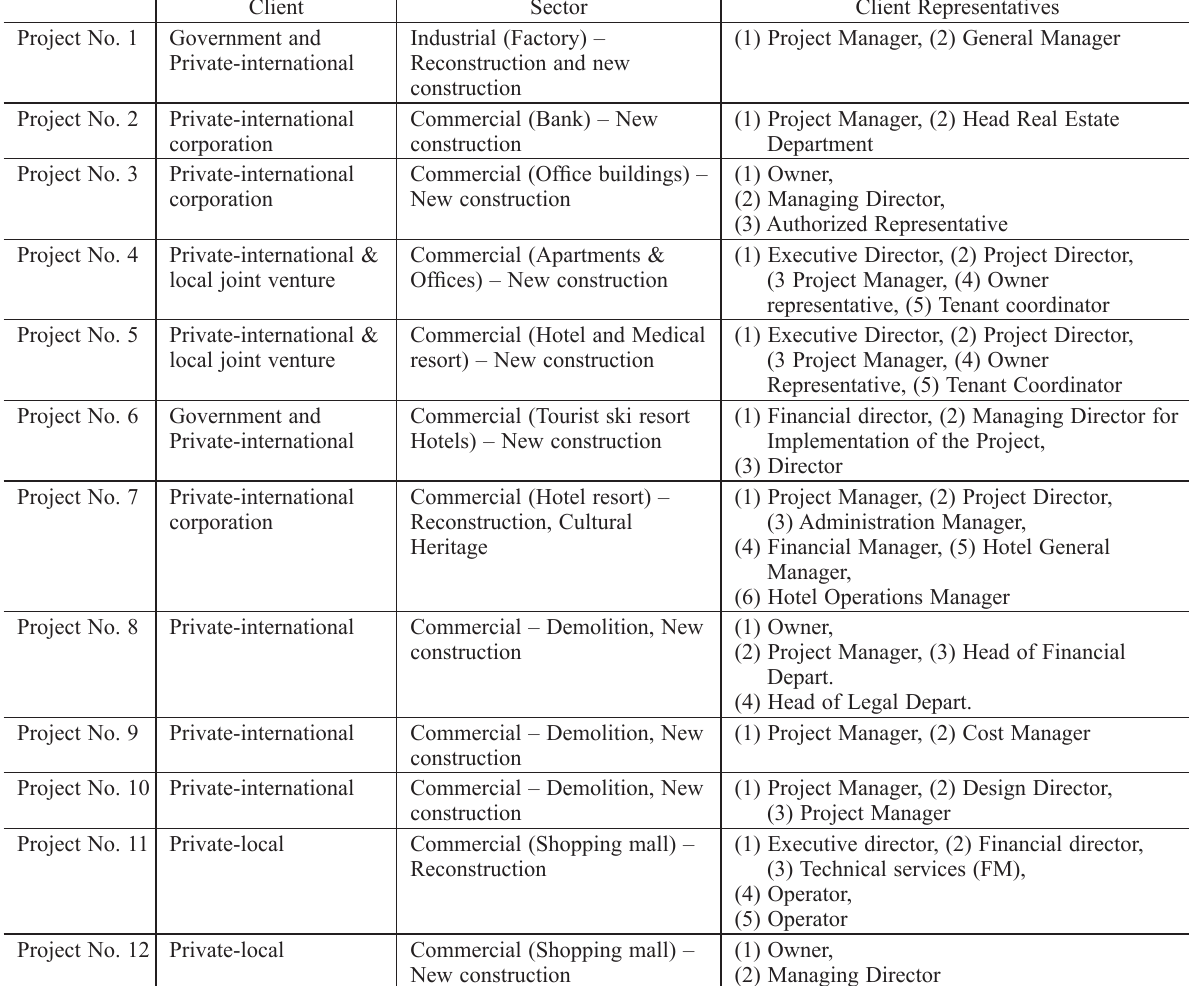
Table B.1. Summary of projects that were used in